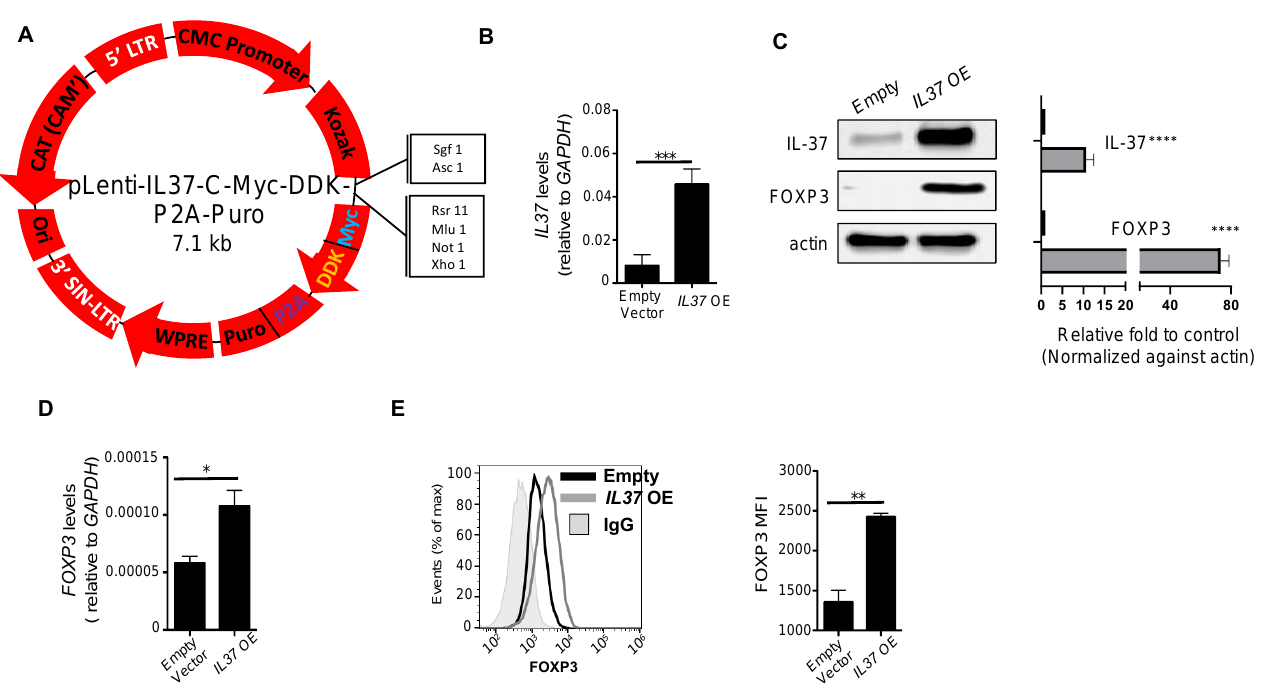
Figure 2. IL37 overexpression induces FOXP3 in Jurkat cells. ( A ) pLenti-IL37-C-Myc-DDK-P2A-Puro vector ( IL37 OE) (Origene). ( B ) qRT-PCR analysis of IL37 mRNA expression in Jurkat cells transfected with an empty vector or IL37 OE. GAPDH served as an internal control, and the values represent IL37 gene expression as a ratio to GAPDH expression. ( C ) IL-37 and FOXP3 immunoblotting of empty vector and IL37 OE Jurkat cells. Actin was used as a loading control. Representative immunoblotting (left panels) and quantification of bands (right panels) of three immunoblot experiments. The band densities of proteins were quantified with Image J, normalized to actin, and expressed as fold changes compared to control Jurkat cells expressing an empty vector. ( D ) FOXP3 mRNA expression in vector control and IL37 OE Jurkat cells. GAPDH served as an internal control, and the values represent FOXP3 gene expression as a ratio to GAPDH expression. ( E ) Flow cytometry analyses of FOXP3 protein expression in vector control and IL37 OE Jurkat cells. Histograms (top) and quantification by mean fluorescent intensity (MFI) (bottom) of FOXP3 expression. IgG used for negative control staining (solid gray histogram). Small horizontal lines indicate mean ± s.e.m. * p < 0.05; ** p < 0.01; *** p < 0.001; **** p < 0.001 (Student’s t test). Data are representative of three independent experiments. Along with elevated FOXP3, IL37 OE Jurkat cells showed elevated gene expression of CTLA4 , IL10 , glucocorticoid-induced TNFR-related ( GITR ), and transforming growth factor- β ( TGF β ) (Figure 3A), markers commonly found on highly suppressive Treg cells [3]. We confirmed elevated CTLA-4 surface protein expression by flow cytometry (Figure 3B). Furthermore, a significant proportion of IL37 OE Jurkat cells expressed IL-10 protein without stimulation, which was further increased with CD3/CD28 stimulation compared to control Jurkat cells (Figure 3C).